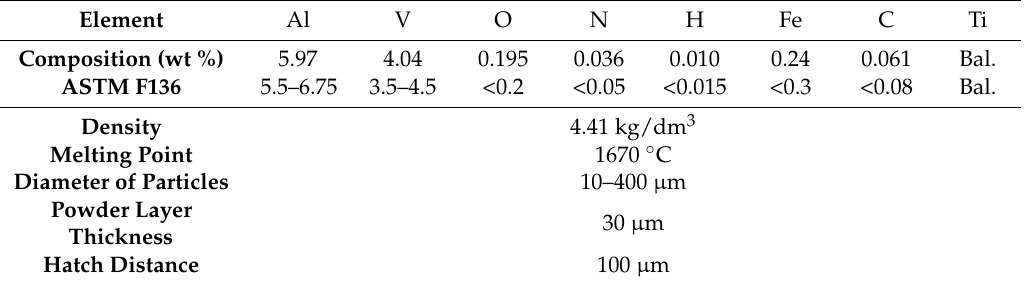
Table 1. Chemical composition and material characteristics of used powder.